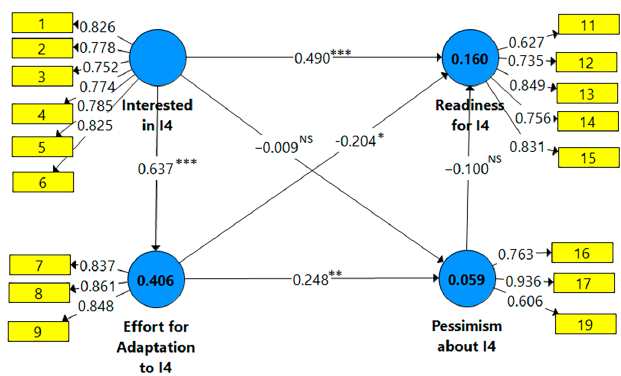
Figure 2. First measurement model